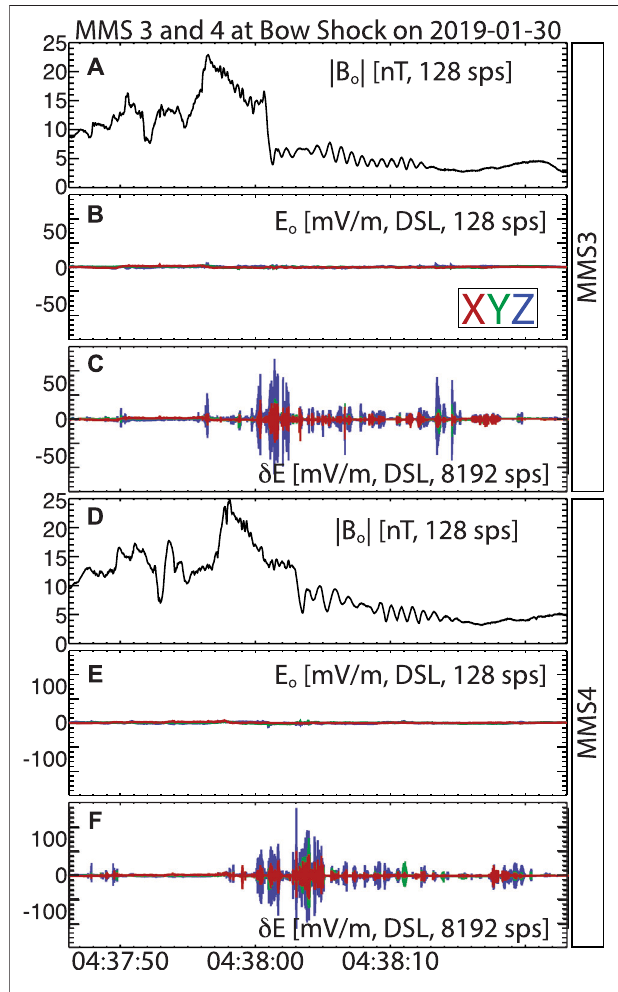
FIGURE 3 | An example terrestrial bow shock crossing observed by MMS3 and MMS4 on 2019-01-30. Panels (A , D) show the magnetic fi eld magnitude (black) vs time at 128 sps observed by the fl uxgate magnetometer (Russell et al., 2016). Panels (B , E) show the DC-coupled electric fi eld components at 128 sps observed by the electric fi eld instrument (Ergun et al., 2016; Lindqvist et al., 2016). Panels (C , F) show the AC-coupled electric fi eld at 8,192 sps. Note that Panels (B , C , E) share the same vertical axis range for direct